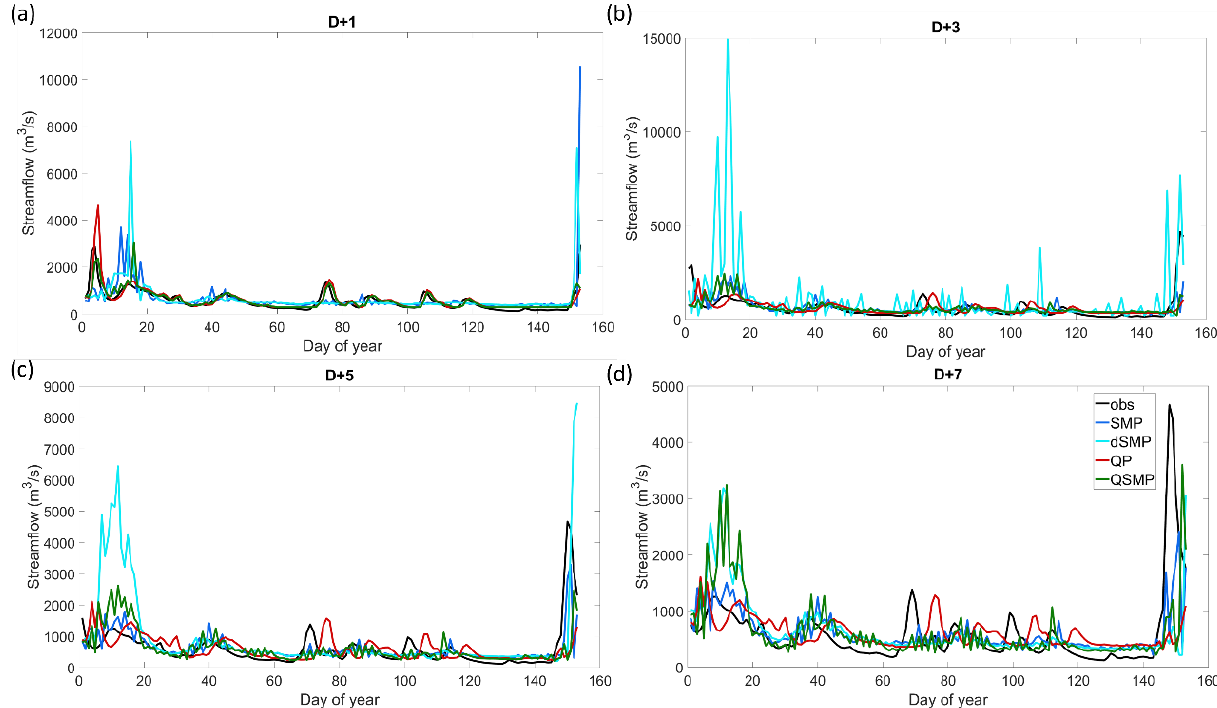
Figure 12. Hydrographs for the Susquehanna watershed for summer 2010 (validation period) ( a ) 1, ( b ) 3, ( c ) 5 and ( d ) 7 days in advance.